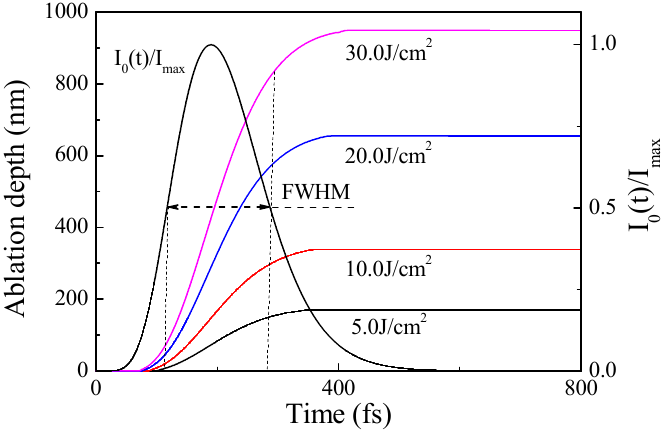
Figure 7. The temperature characteristics under four different laser fluence ( τ 0 = 1.0 × 10 − 13 s).